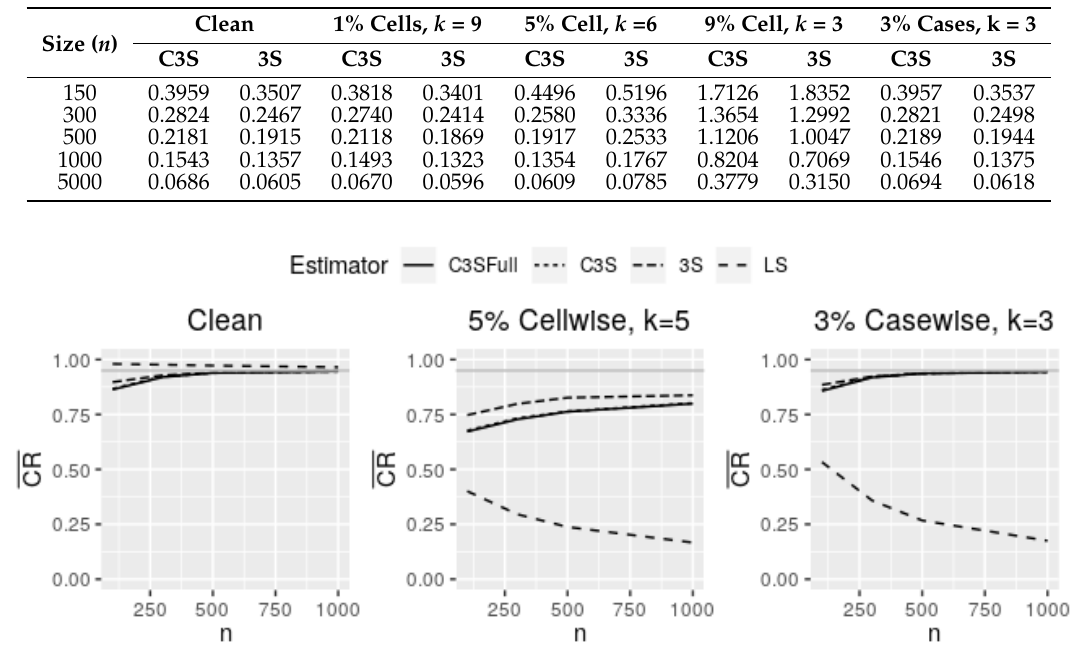
Figure 7. CR for clean data and for cell-wise and case-wise contaminated data with the indicated n . Source: the authors.